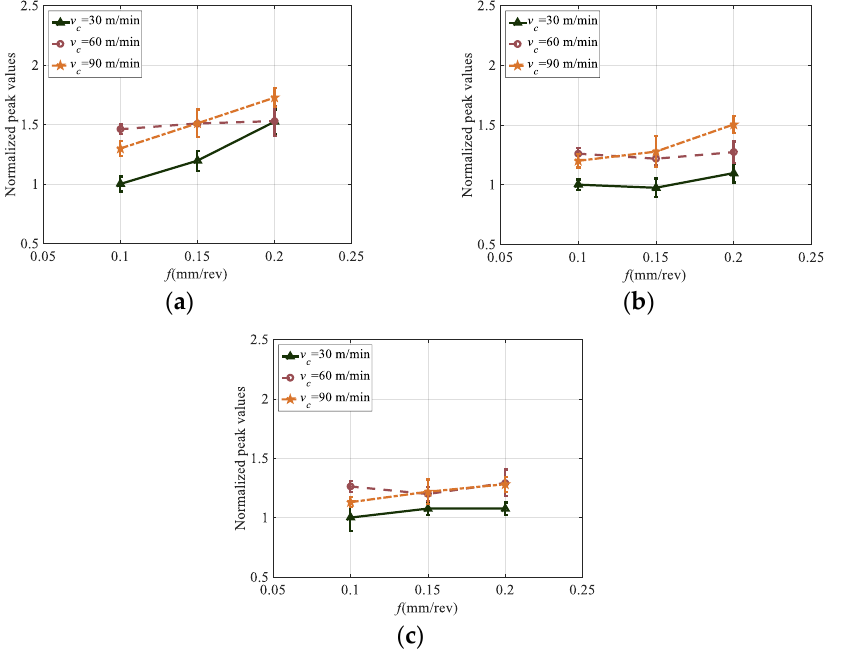
Figure 9. The influence of feed rate on milling forces: ( a ) Case 1 (milling in XY plane), ( b ) Case 2 (milling in XZ plane), ( c ) Case 3 (milling in YZ plane) for the workpiece built with the SSR of 67°.